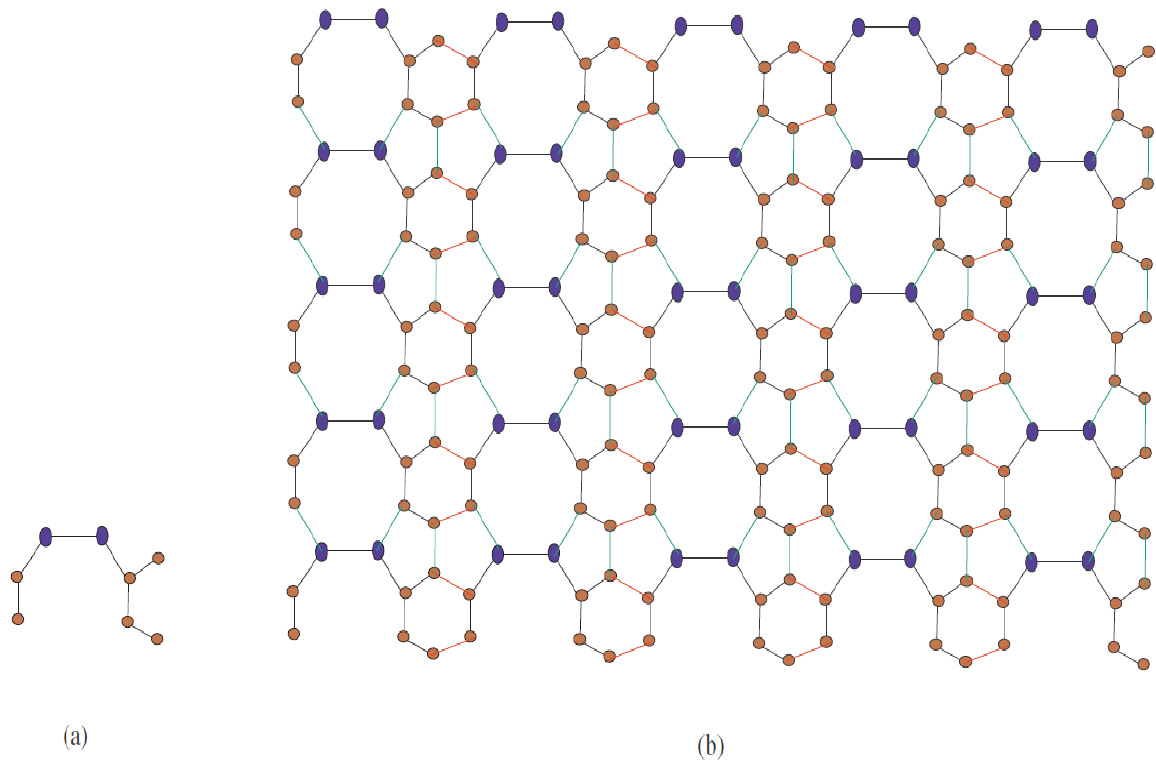
- III [ n,m ], (a) One dimensional cell, (b) SiC 3